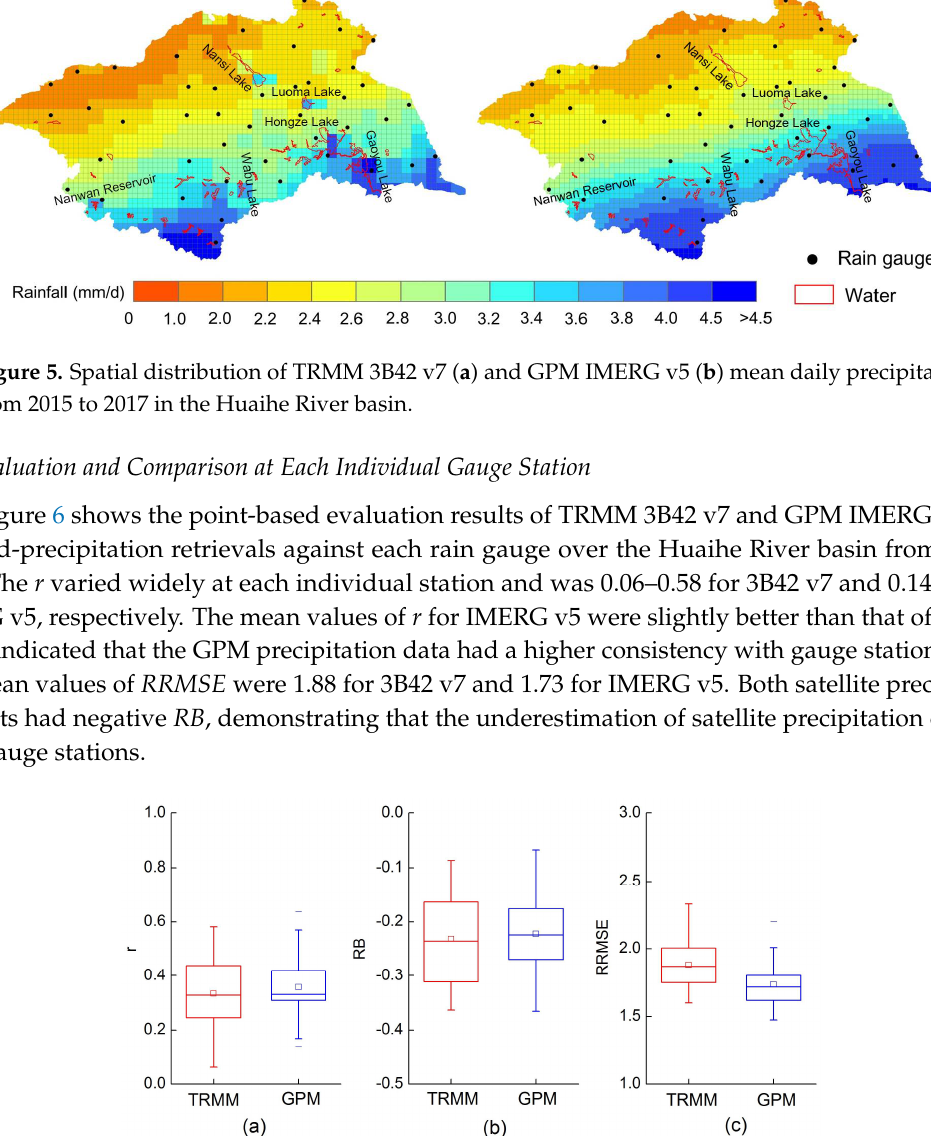
Figure 6. Evaluation results of TRMM 3B42 v7 and GPM IMERG v5 daily precipitation at individual gauge stations: ( a – c ) represent r , RB and RRMSE , respectively.